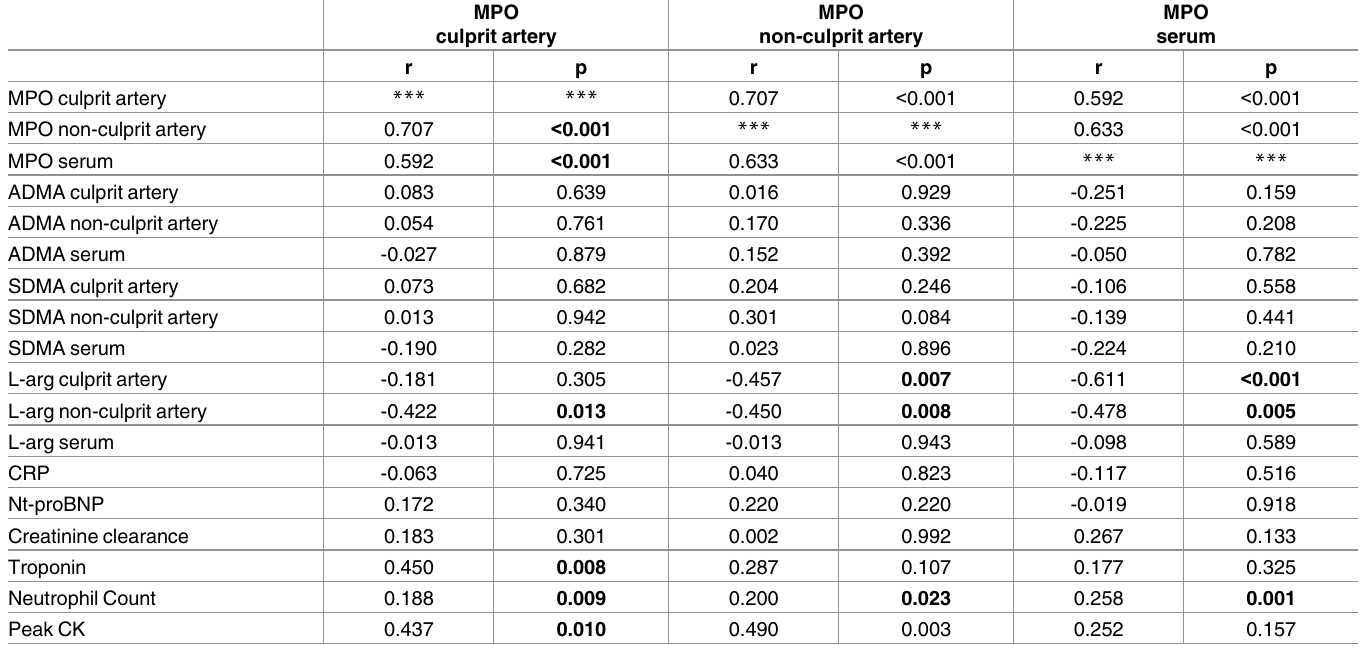
Table 3. Determinants of the MPO value in univariate regression (n = 40).